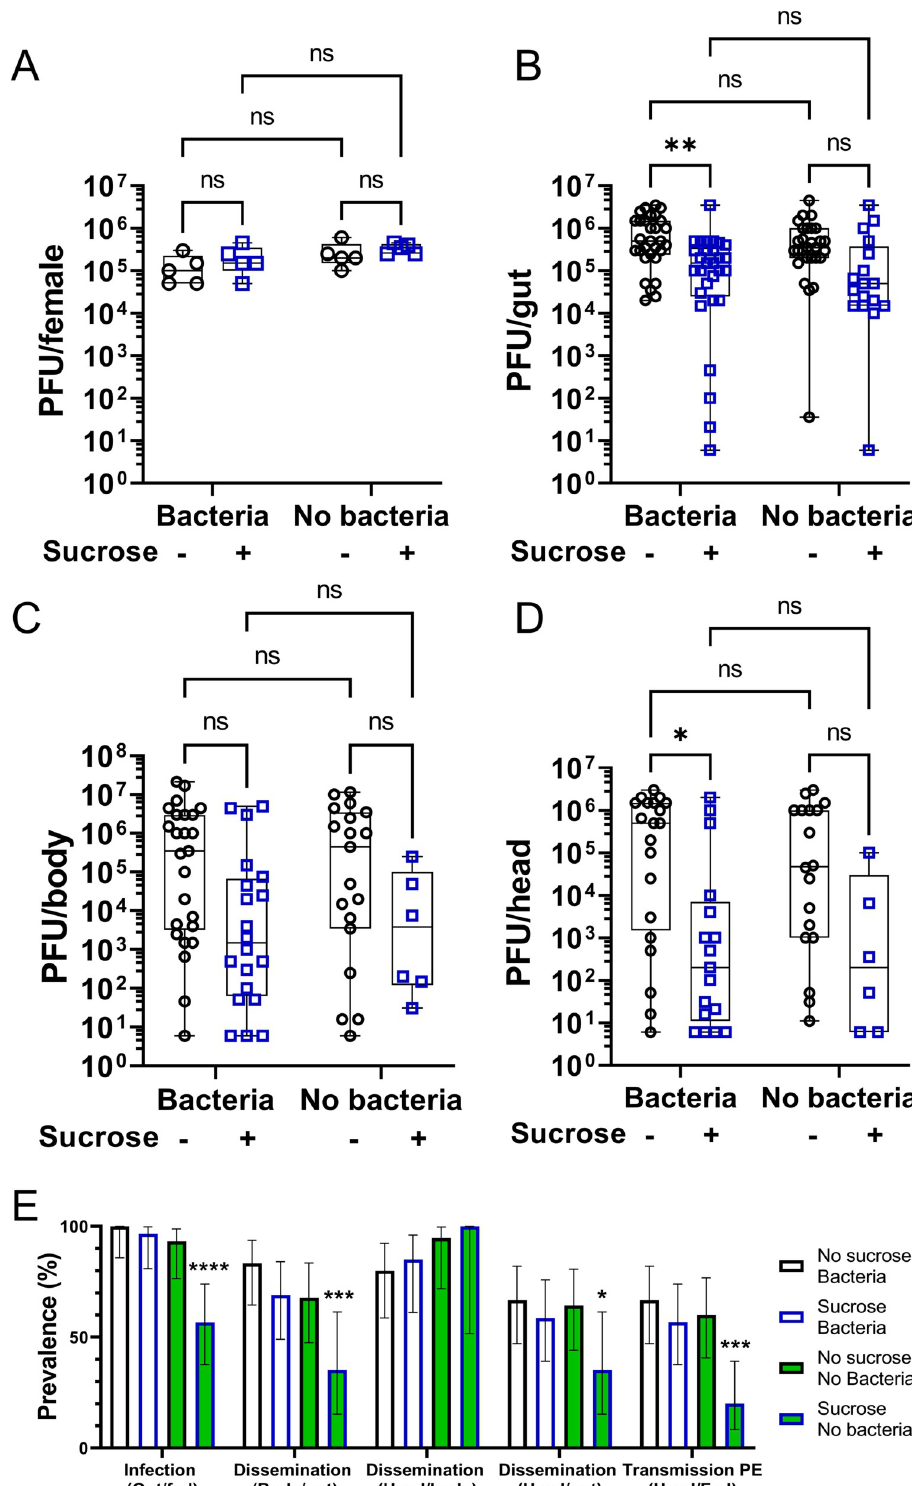
Fig 6. Sugar feeding protects the female mosquito Ae . aegypti against SFV infection. Females were treated as in Fig 5A. All females were given access to sucrose solution 30 h after the infectious blood meal. (A) Virus titration by plaque assays of individual females sacrificed straight after blood meal to assess infectious particles ingested. N = 5 per